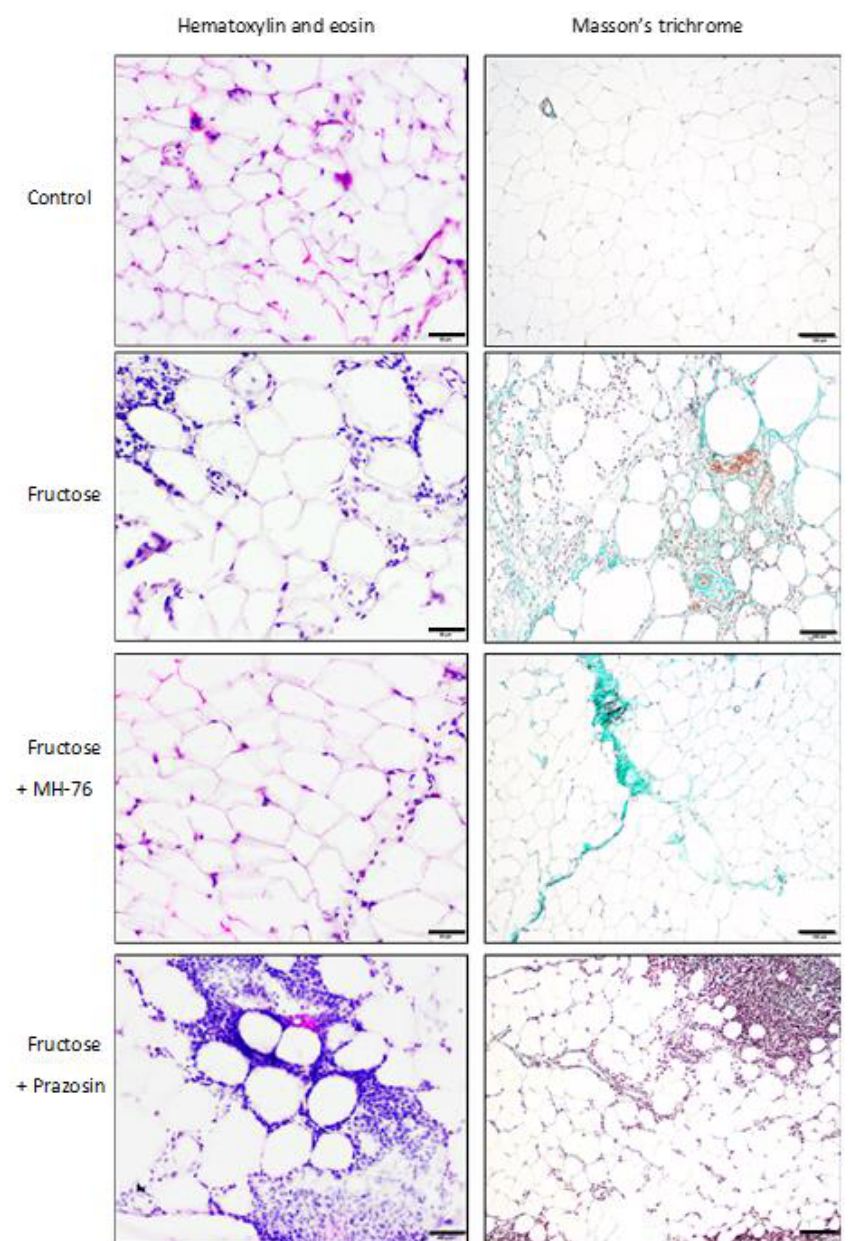
Figure 5. Representative histological pictures of abdominal adipose tissue sections stained with hematoxylin and eosin (bar = 20 µ m) and Masson’s trichrome (bar = 100 µ m). Massive amount of inflammatory cells, fibrosis and adipocyte hypertrophy are visible mainly in the Fructose and Fructose + Prazosin rats. Slight inflammation involving mostly septa are seen in the Fructose + MH-76 rats, which suggested the anti-inflammatory effect of this